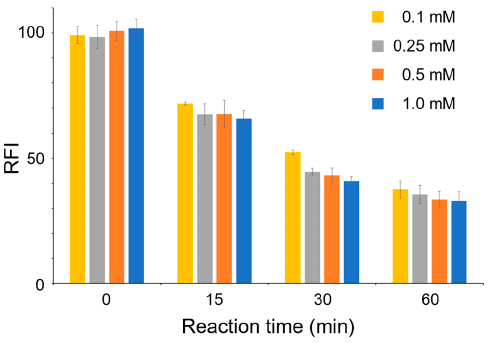
Figure 3. The effect of PRPP concentration on fluorescence intensity obtained after OPRT reaction followed by the fluorogenic reaction with 4-TFMBAO. All experiments were repeated three times on different days.